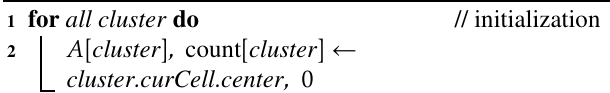
Algorithm 1: PROFILE-Training ( D , g